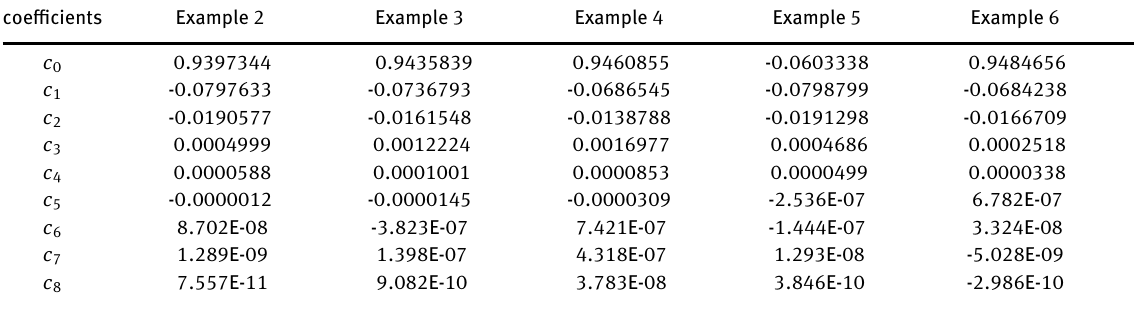
Table 4: The value of the unknowns vector C T for discussed examples for N = 8 .